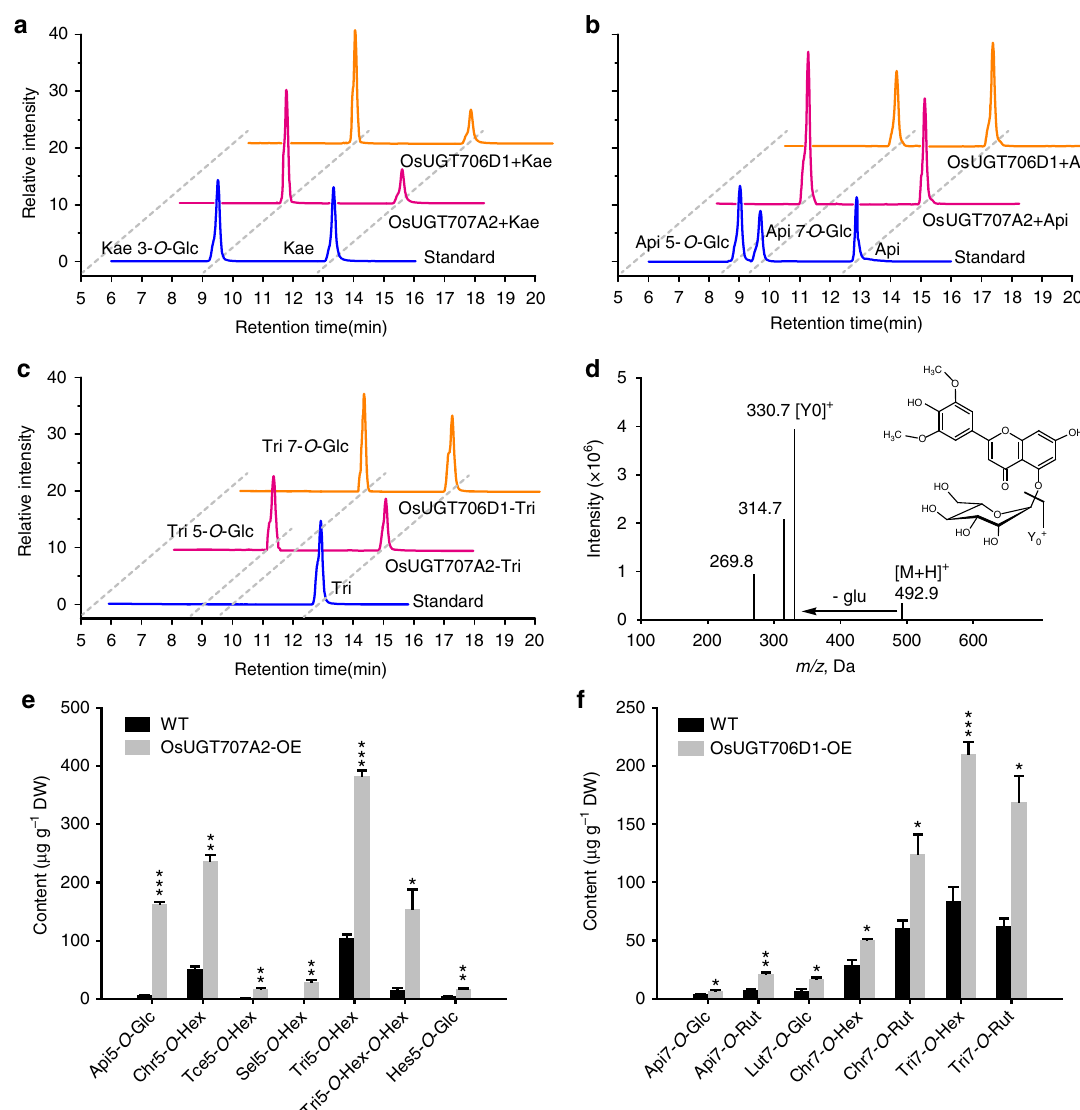
Fig. 2 Functional analysis of OsUGT706D1 and OsUGT707A2 . HPLC chromatograms of the reaction of OsUGT706D1 and OsUGT707A2 with UDP-glucose and different substrates, kaempferol ( a ), apigenin ( b ) and tricin ( c ). Chromatograms show the absorption at 330 nm. d The MS spectrum and chemical structure of the product in the reaction of OsUGT707A2 with UDP-glucose and tricin. Bar plots for the contents of fl avone 7- O -glycosides and fl avonoid 5- O -glycosides in overexpression lines of OsUGT707A2 ( e ) and OsUGT706D1 ( f ). The data are presented as mean ± SD, n = 3. * P < 0.05, ** P < 0.01, *** P < 0.001, Student ’ s t tests. Api apigenin; Kae kaempferol; Tri tricin; Sel selgin; Tce 3 ′ ,4 ′ ,5 ′ -tricetin; Glc glucoside; Hex hexoside; Rut rutinoside, Chr chrysoeriol; Hes hesperetin; WT the transgenic background variety